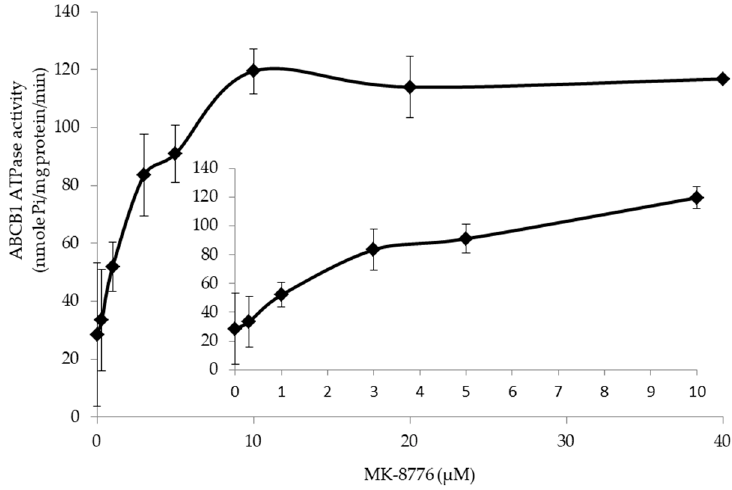
Figure 5. MK-8776 stimulated the ATPase of P-gp.